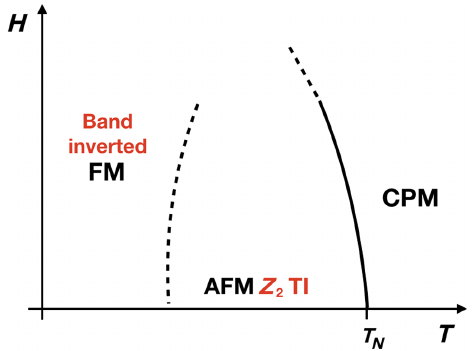
FIG. 6. Schematic topological phase diagram of MnBi 4 Te 7 . The scheme follows the experimentally observed trends: a correlated paramagnetic state above T , followed by an antiferromagnetic N phase that at lower temperatures evolves to a magnetic state with a strong ferromagnetic component. The text in red highlights possible nontrivial topology (see text for